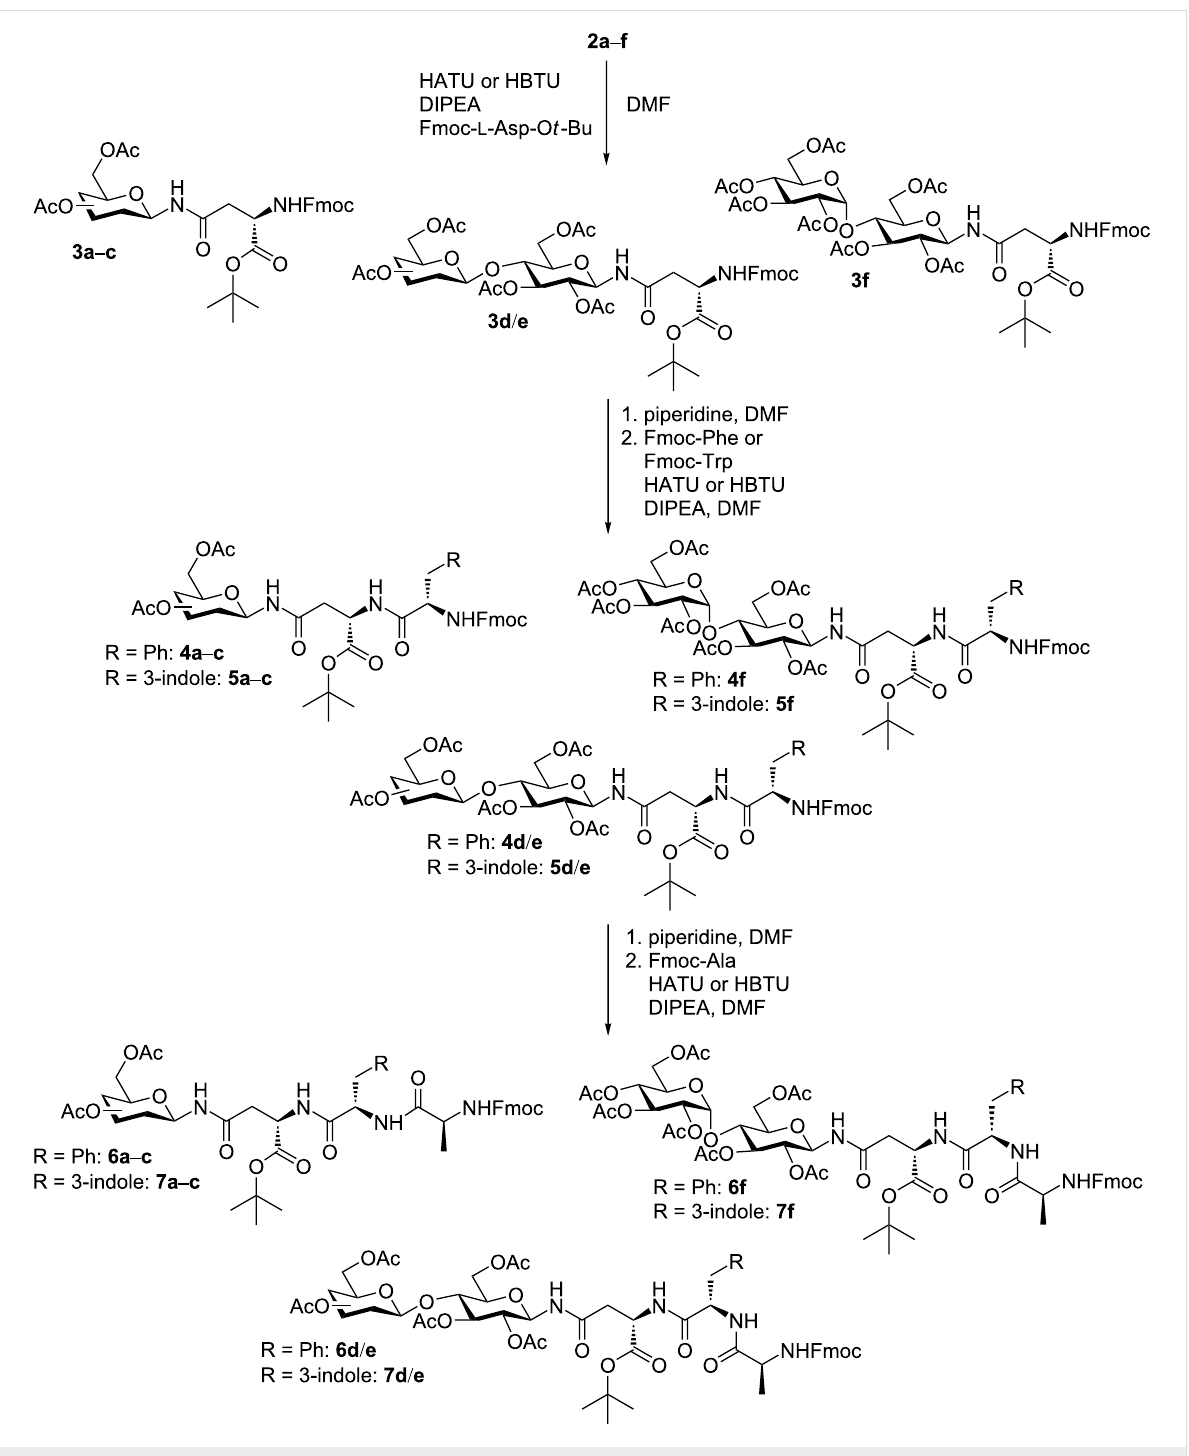
Scheme 2: Peptide coupling reactions, including the previous Fmoc